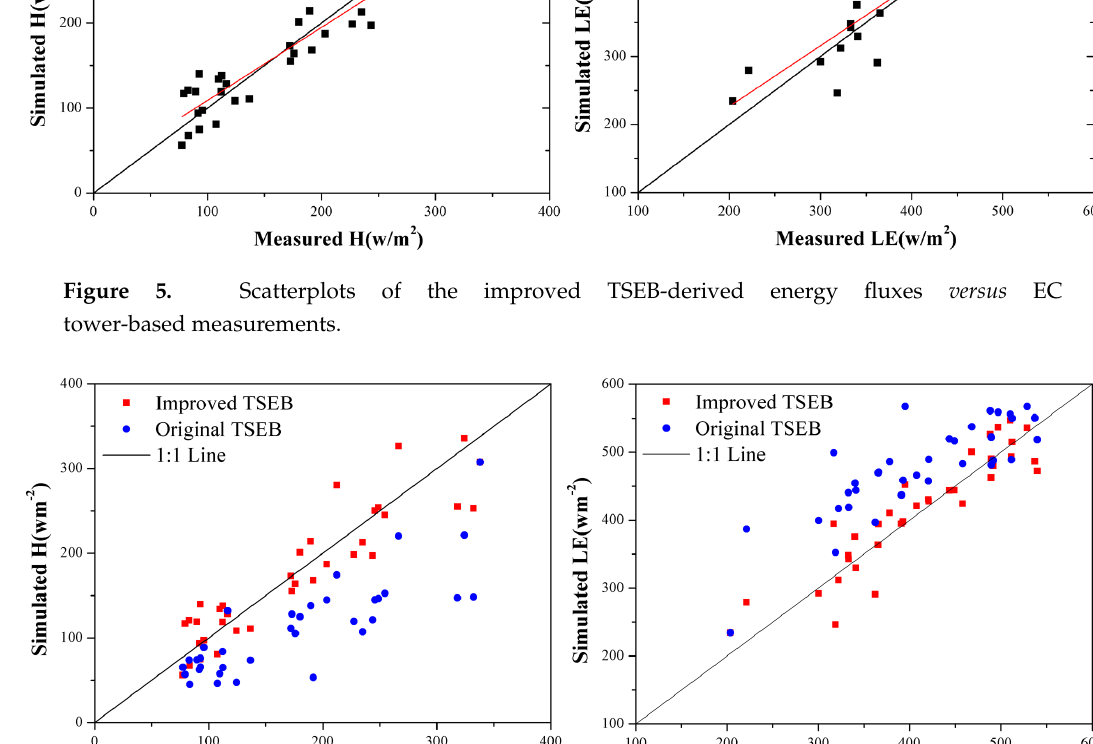
Figure 6. Comparisons of the sensible and latent heat fluxes obtained from the improved and original TSEB models with tower-based measurements.